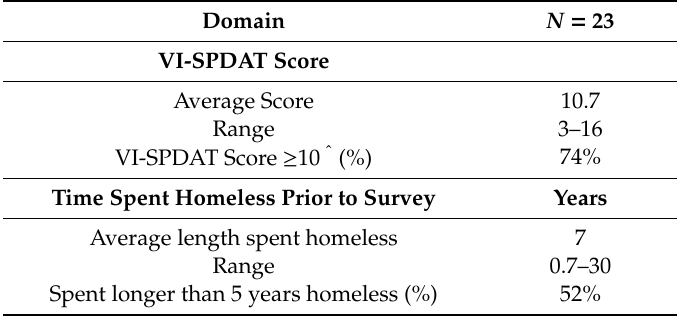
Table 2. VI-SPDAT domains for individual Wongee Mia family